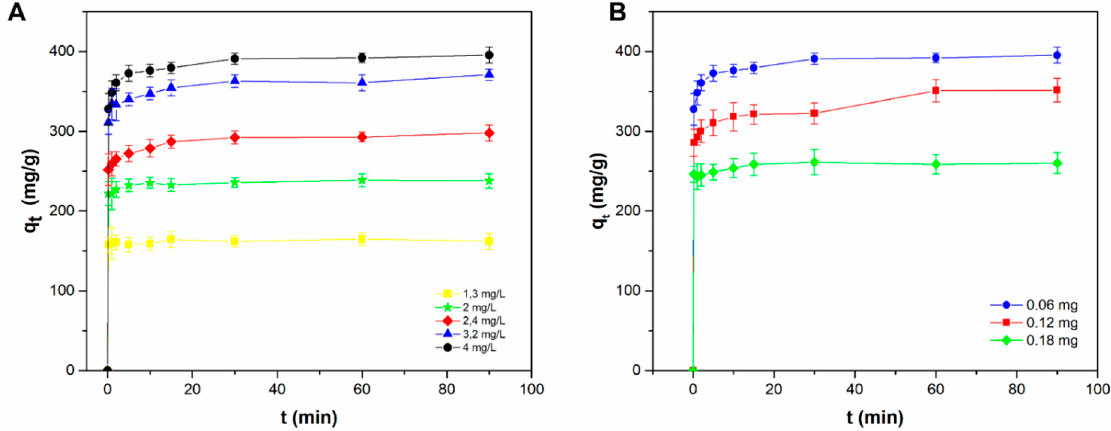
Figure 5. ( A ) Variation of MB adsorption capacity on Liposomes@PDA microspheres as a function of contact time as the initial dye concentration varies. Adsorbent mass: 0.06 mg; temperature: 298 K; pH = 8.0; equilibration time: 90 min. ( B ) Variation of MB adsorption capacity on Liposomes@PDA microspheres as a function of contact time at different mass of adsorbent Liposome@PDA. MB: 4 mg L − 1 ; temperature: 298 K; pH = 8.0; equilibration time: 90 min. Table 1. Comparison of adsorption capacities of different PDA-based adsorbents for MB removal at 298 K.